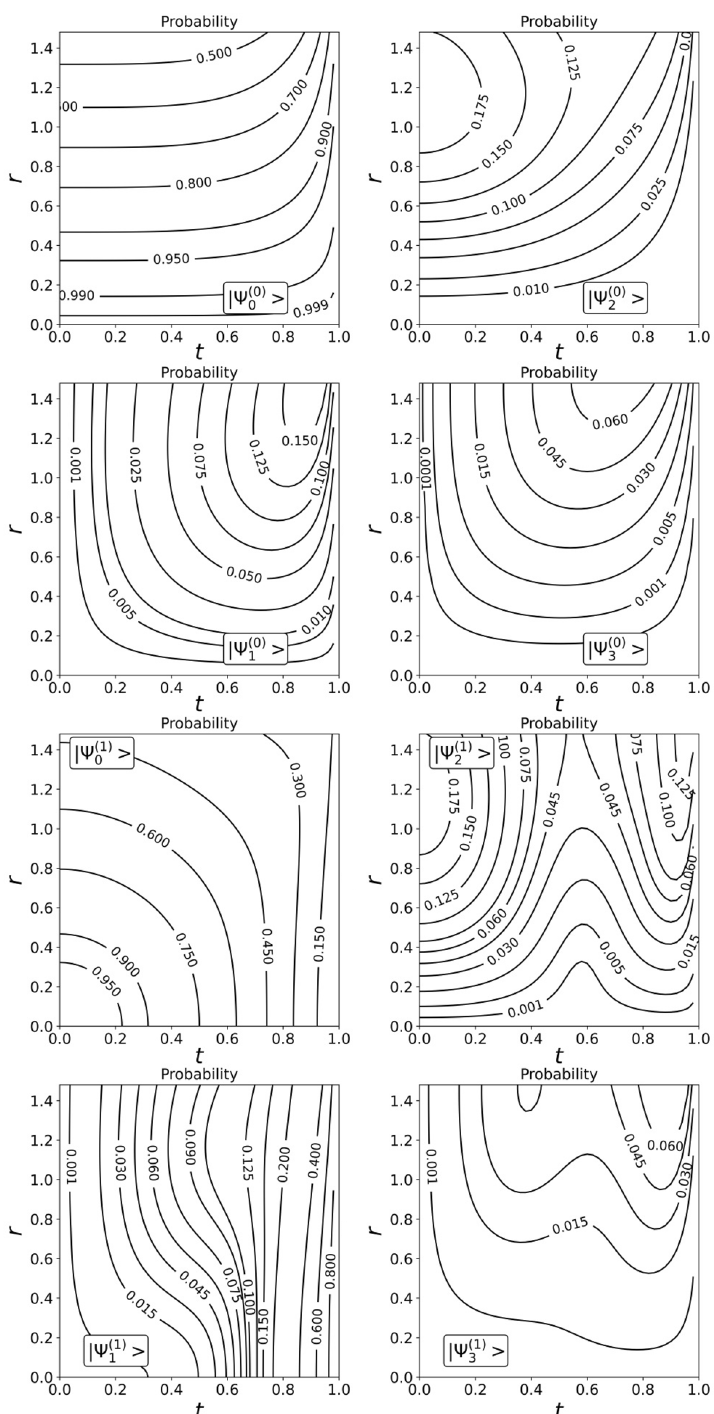
const ) as a function of t and r for =